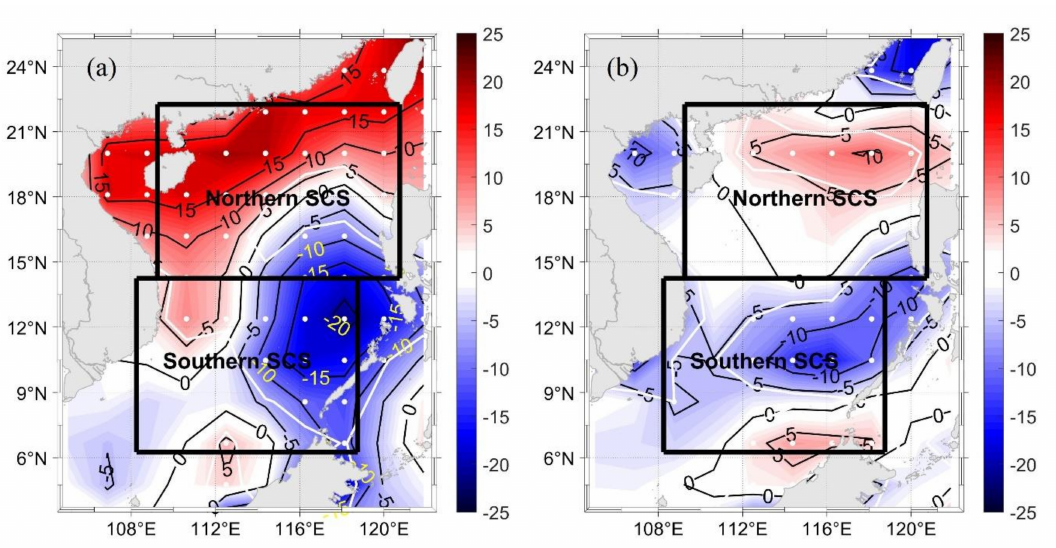
Figure 6. The composites of net heat flux anomalies (in W / m 2 ) during mature winters of ( a ) EP El Niño and ( b ) CP El Niño events. The white contours filled with dots indicate the composite exceeding the 90% significance level based on a Student’s t test.